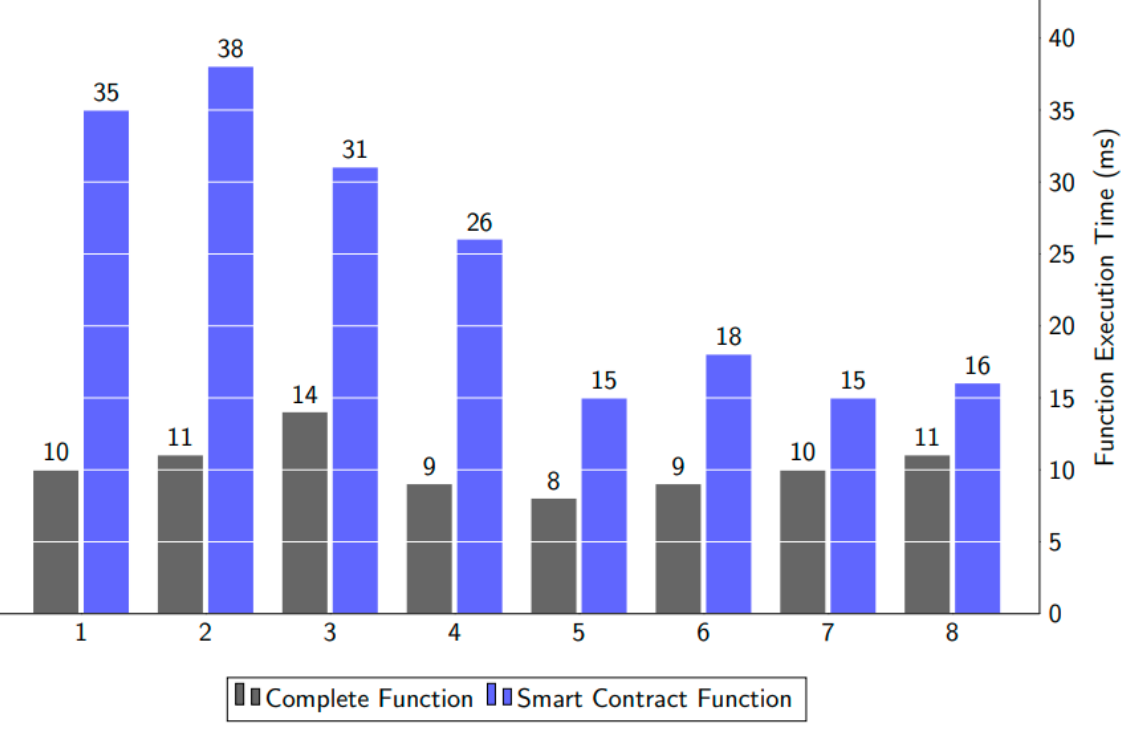
Figure 8. Computational time for function execution to store the data in the IPFS and blockchain.